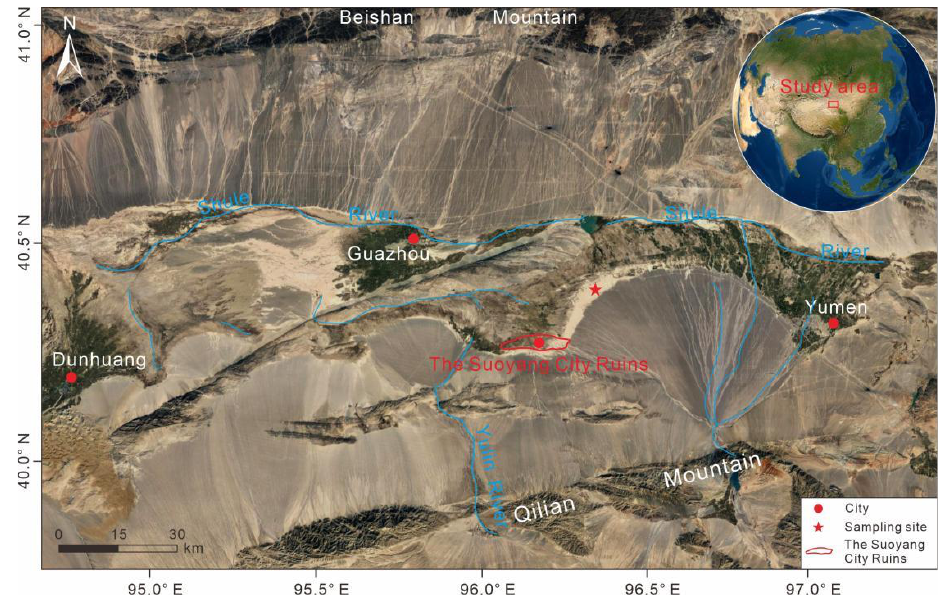
Figure 1. Locations of the Suoyang City ruins in Guazhou basin and the sample site.